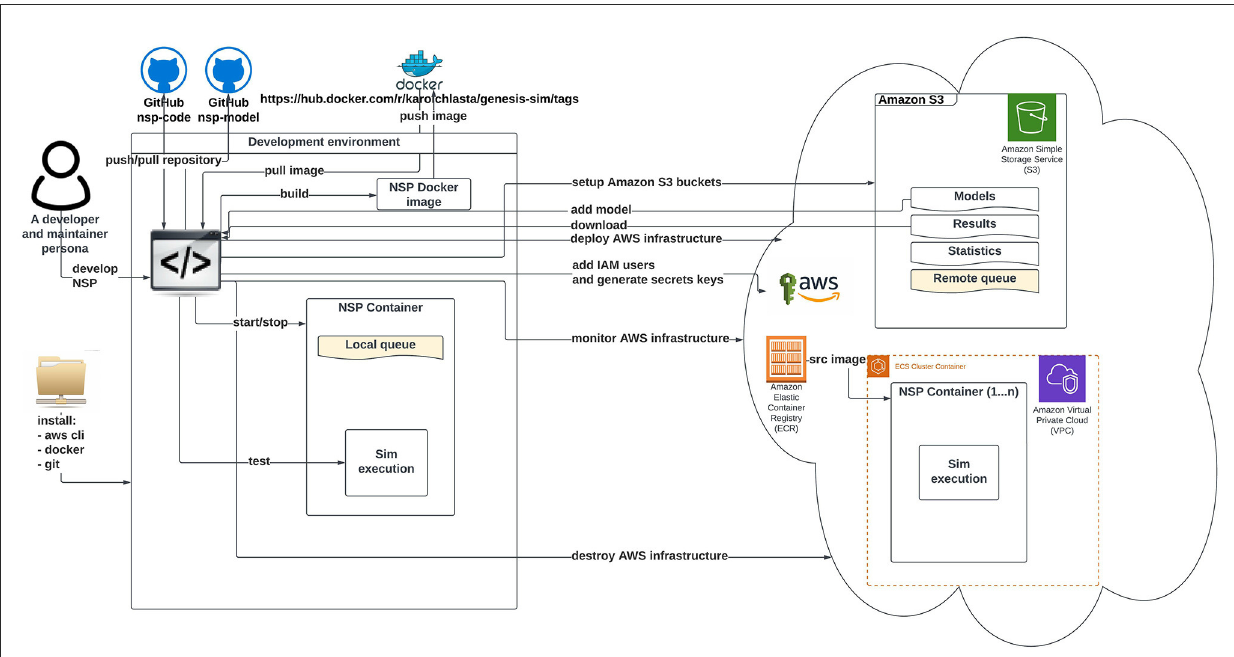
FIGURE3 Schematic diagram of neural simulation pipeline showing a developer and maintainer workflow. This persona interacts with the system via Git client (code), AWS CLI, and AWS Management Console.